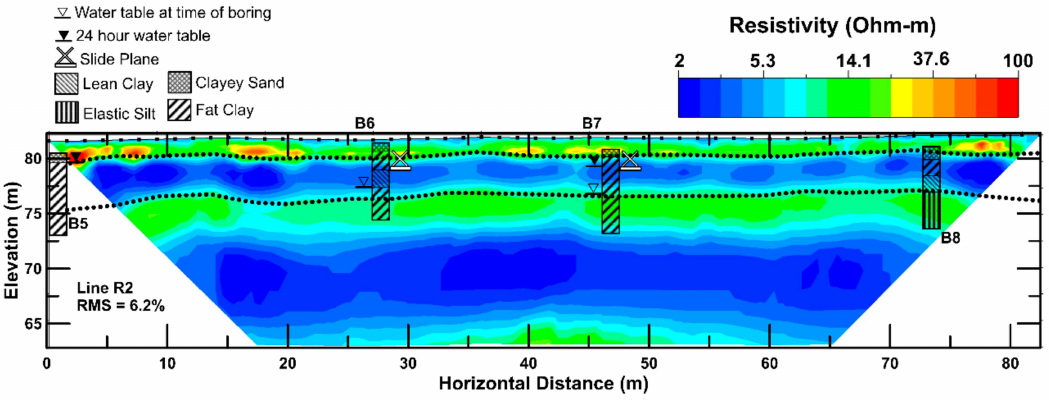
Figure 4. Inverted resistivity profile for line R2 with boring information and estimated slide plane